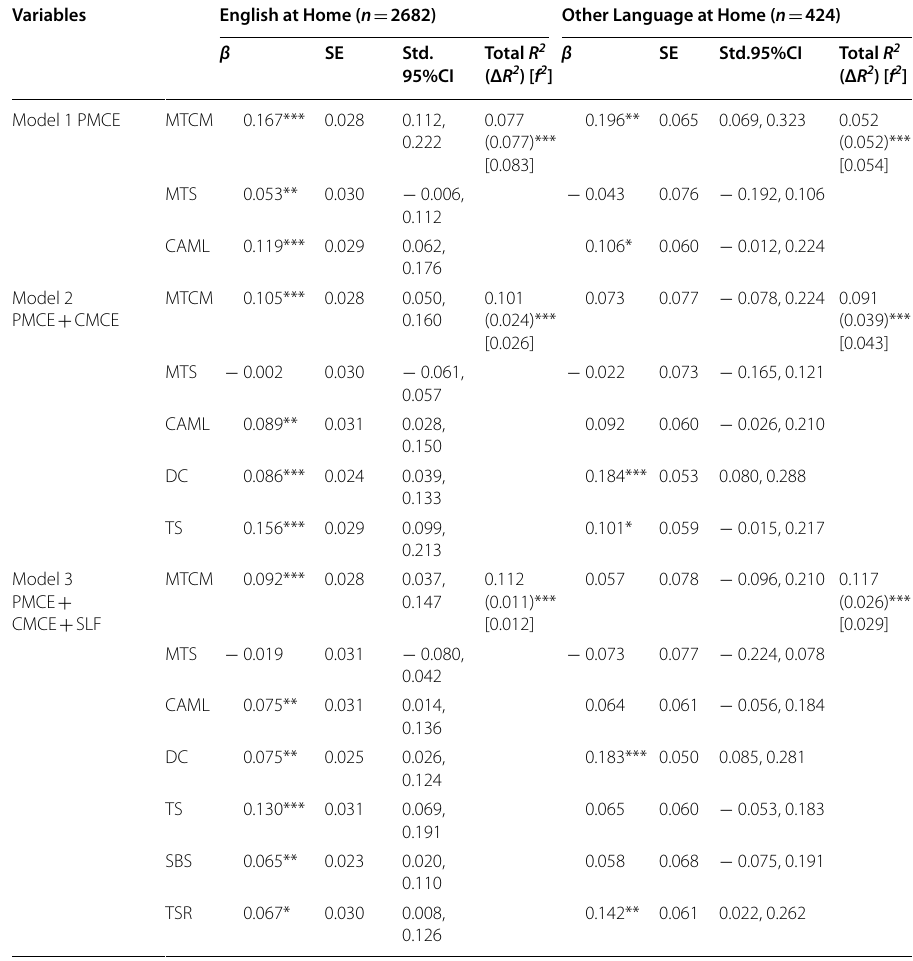
Table 2 School and Classroom Climate Contributions to Mathematics Self-Concept: Hierarchical Regression Model Results Disaggregated by International Language at